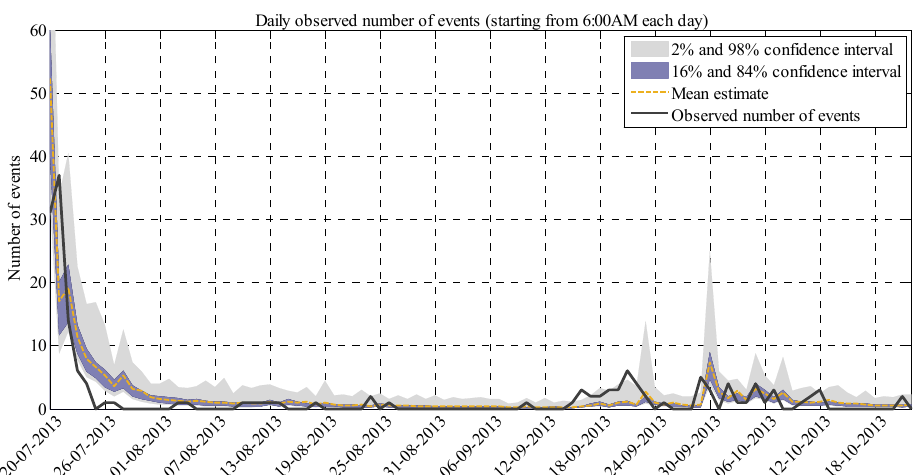
Figure 5. The statistics of the daily number of events having magnitude greater than the cut-off magnitude N ( m ≥ M ct | seq , M ct ), M ct = − 0.5 in the period starting from first forecast interval: 2013-07-20 6:00 A.M.–2013-07-21 6:00 A.M. (24 h) to the last forecast: 2013-10-22 6:00 A.M.–2013-10-23 6:00 A.M. (24 h). The statistics are represented by the 2nd–98th (grey area) percentiles and 16th–84th (blue area) percentiles confidence intervals and the mean (expected value from Equation (5)). The reference time is T o = 2013-07-14 at 12:00. The evolution of the observed number of events is shown with black-solid line.